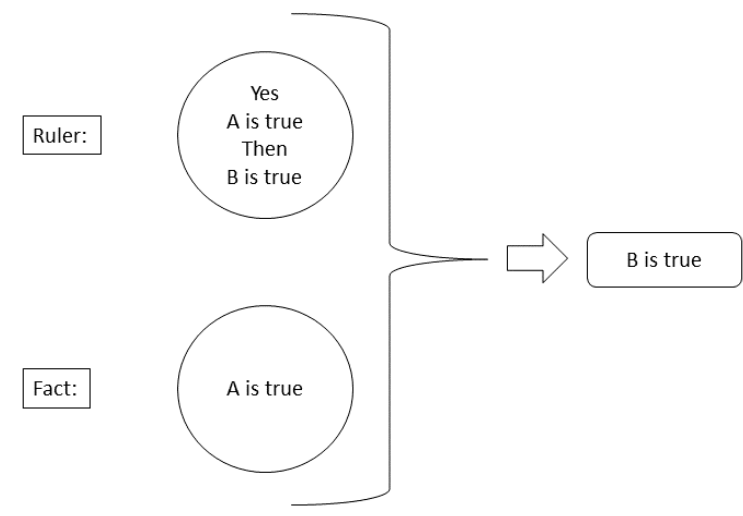
Figure 6. Functioning of a model based on modus ponens rules.